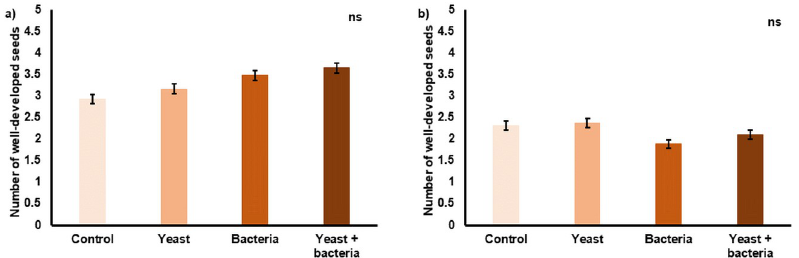
Fig 5. Average seed set per fruit (N = 120) for each inoculation treatment applied in 2019 (a) and 2020 (b). Treatments included inoculation of flowers with Metschnikowia reukaufii (yeast), Acinetobacter nectaris (bacteria), and a combination of both (yeast + bacteria). As a control, flowers were sprayed with water. There were no significant (P > 0.05) differences among treatments. Error bars represent standard errors of the mean.